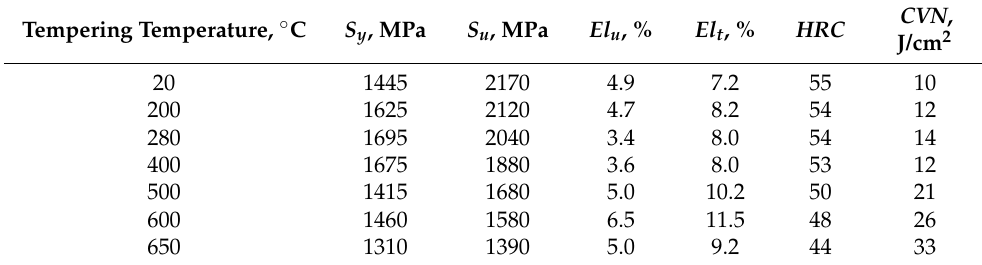
Figure 3. Engineering curves ( a ) and true-stress – true-strain curves ( b ) at room temperature of the 0.4%C-1.6%Si-1%Cr-0.95%Mo steel with V and Nb after quenching (Q) and different tempering (T) temperatures. Table 1. Mechanical properties of 0.4%C-1.6%Si-1%Cr-0.95%Mo steel with V and Nb after quenching from 900 ◦ C into water and tempering at different